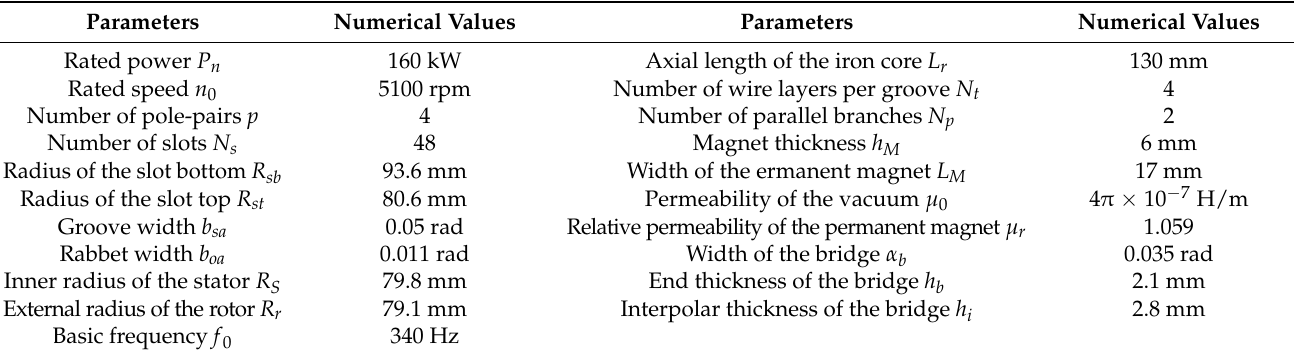
Table 2. The main parameters of IPMSM.